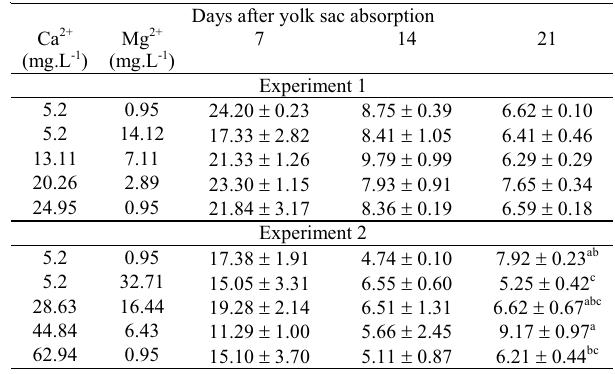
Table 5. Specific growth rate (SGR, %.day -1 ) of silver catfish larvae as a function of Ca 2+ and Mg 2+ concentrations in the water. Means (±SEM) with different letters in the same col- umn and experiment are significantly different (P < 0.05) as determined by ANOVA and by the Tukey test. First line of each experiment is the treatment with water hardness of 20 mg.L -1 CaCO 3